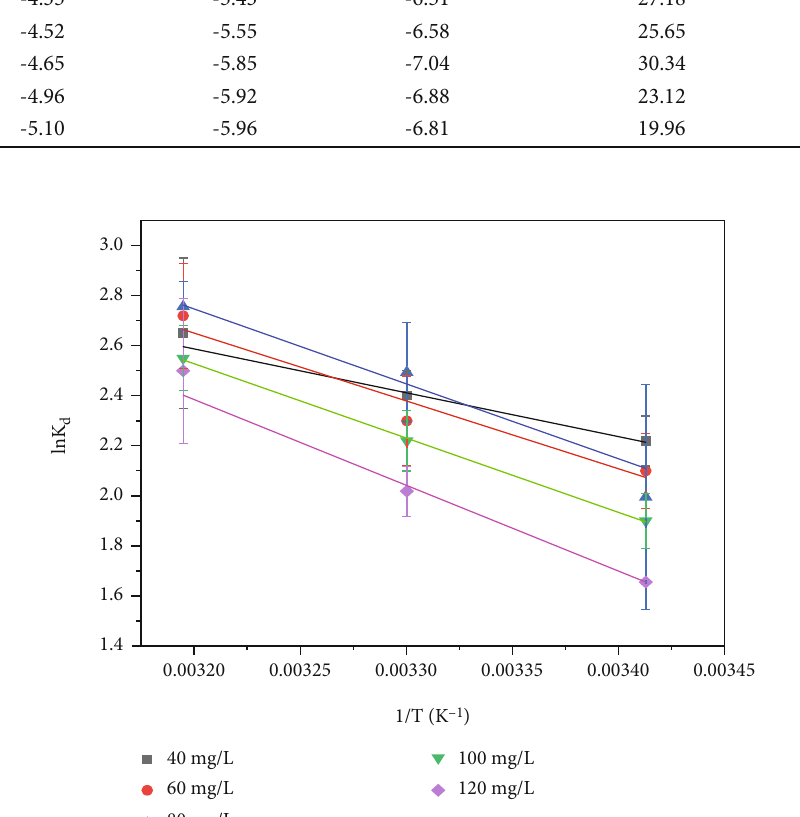
Figure 12: Thermodynamic fi tting diagram of GO adsorption by red